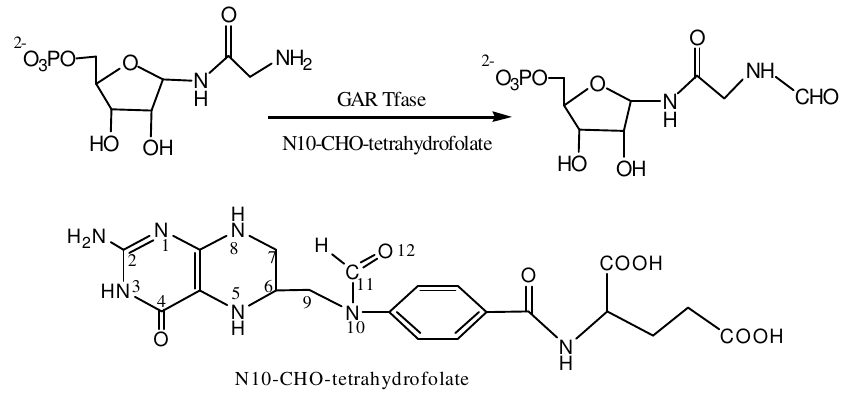
Fig. 1 The GAR Tfase catalyzed reaction and the molecular structure of